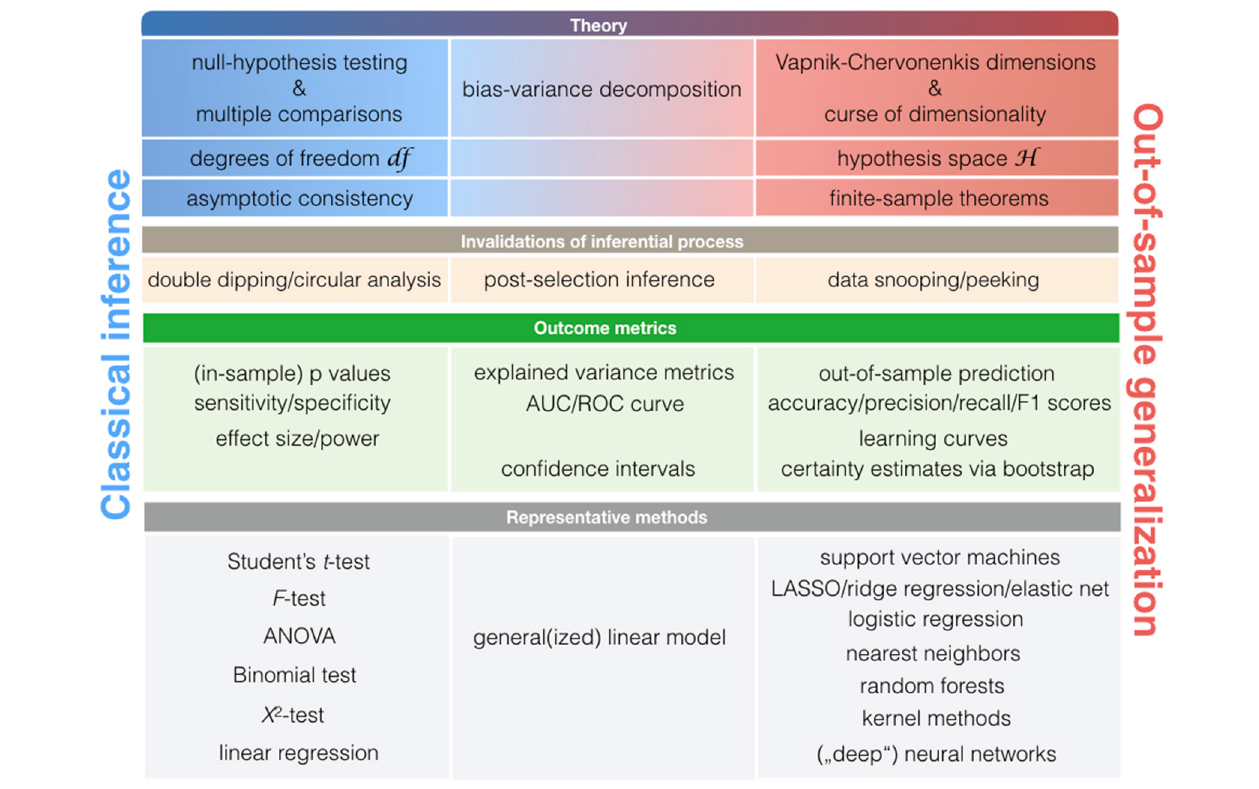
FIGURE 4 | Key concepts in classical statistics and statistical learning. Schematic with statistical notions that are relatively more associated with classical statistical methods (left column) or pattern-learning methods (right column). As there is a smooth transition between the classical statistical toolkit and learning algorithms, some notions may be closely associated with both statistical cultures (middle